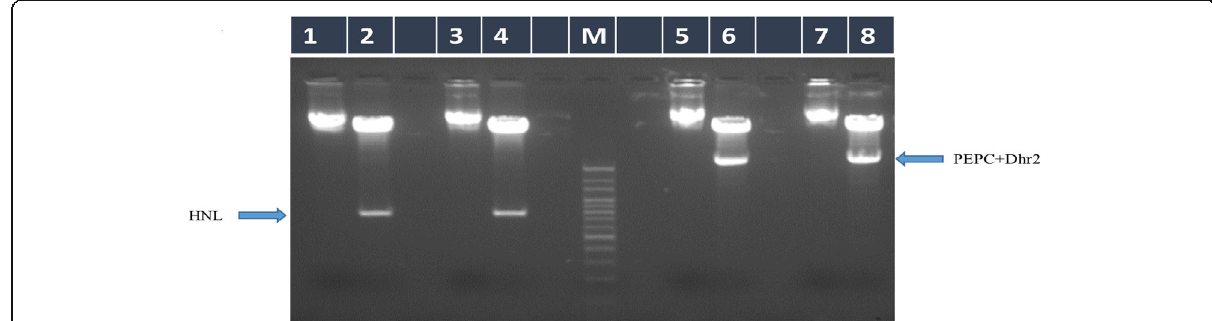
Fig. 4 Agarose gel electrophoresis of restriction enzyme digestion of pTH2 by Eco RI and Sac I, lane 1&3 are uncut pTH2 plasmids, lanes 2 & 4 pTH2 are digested, lanes 5 & 7 are uncut pTD2, lanes 6 & 8 pTD2 are digested with Eco RI and Kpn I, M is a 2 000 bp DNA marker